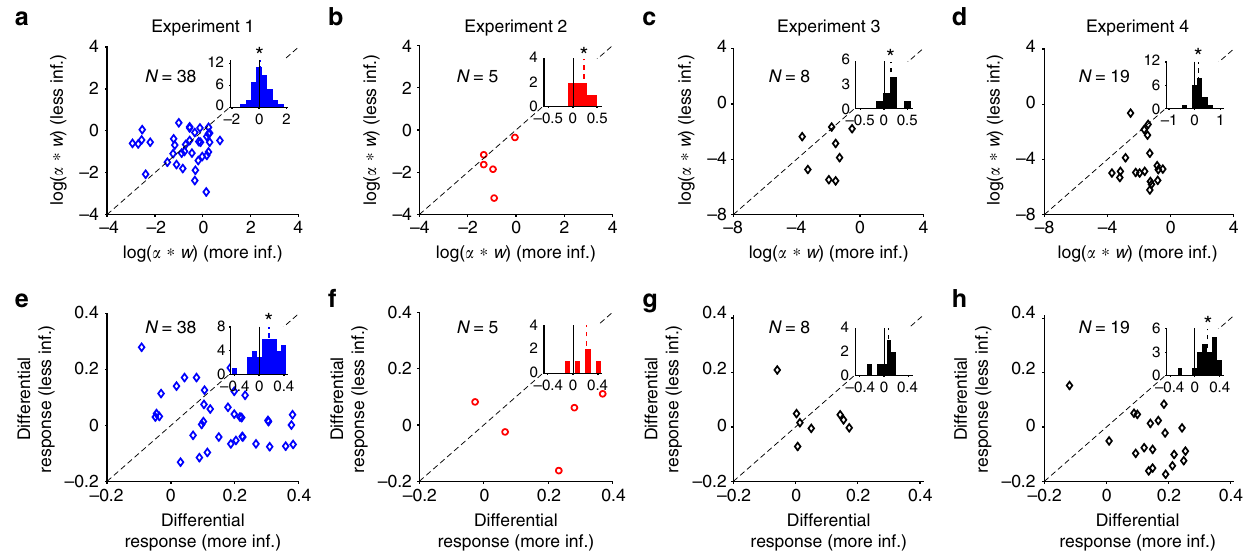
Fig. 5 Feature-based learning was stronger for the more informative feature. a – d Plotted is the log product of the estimated learning rate ( α ) and assigned weight ( w ) for the less informative feature (non-informative in the case of Experiments 2 – 4) vs. of the same product for the more informative feature for each individual, across four experiments. The insets show the histogram of difference in ( α × w ) between the more and less informative features. The dashed lines show the medians and the solid gray lines indicate zero. The star shows that the median of the difference in ( α × w ) were signi fi cantly different from 0 (one-sided sign-rank test, P < 0.05). These products were larger for the more informative feature in all experiments. e – h . Plotted is the feature- based differential response for the less informative feature vs. the more informative feature. Conventions are the same as in a – d . The feature-based differential response was larger for the more informative feature in all experiments (though it did not achieve signi fi cance in Experiments 2 and